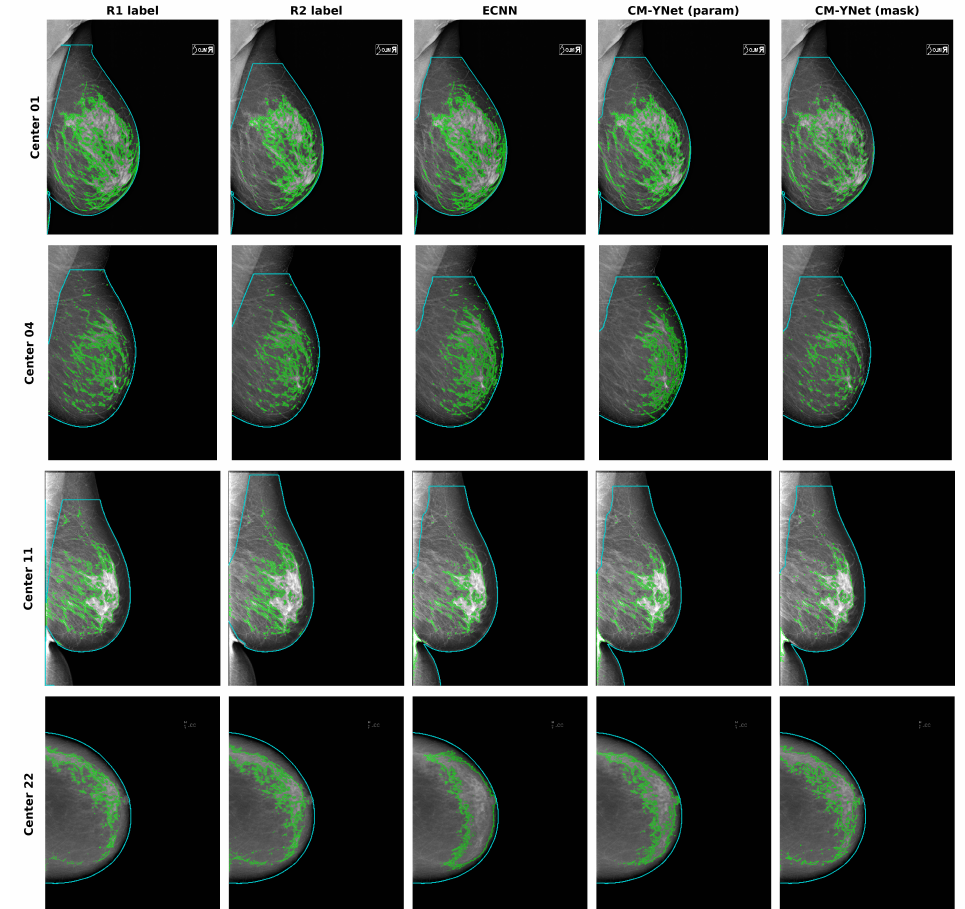
Figure 6. Segmentation examples for ECNN and CM-YNet compared to radiologist labels on different devices. The device of center 01 is of higher pixel-image resolution than the device of center 04. The example from center 22 is a low quality image from the IMIM dataset where the higher performance of CM-YNet (mask) is easily identified. Medio-lateral oblique mammograms were selected so the exclusion of the pectoral muscle could be seen; however, the abdomen was not excluded (center 11).